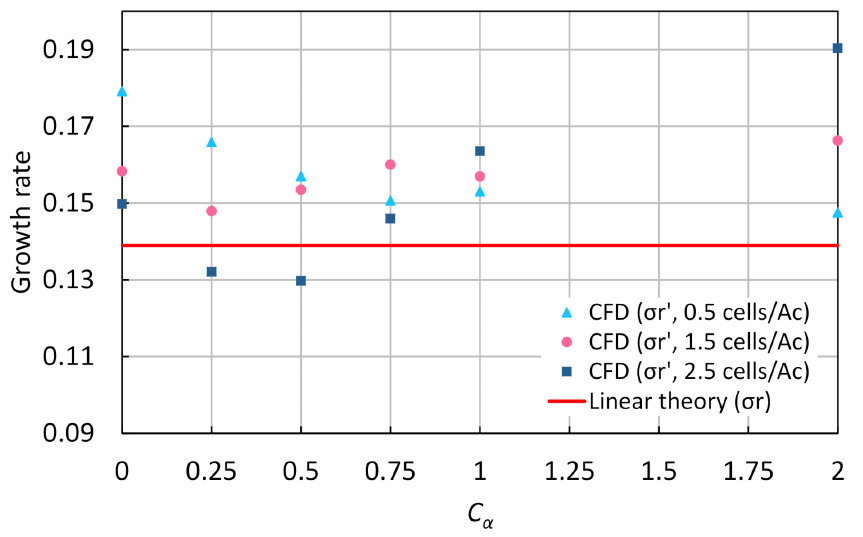
Figure 11. Effect of the interface compression (IC) coefficient ( C α ) on the growth rate, at We g =